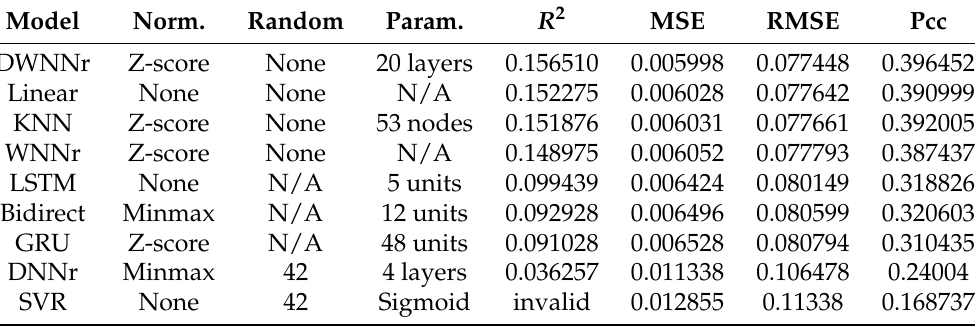
Table 11. Overall Performance in ROC